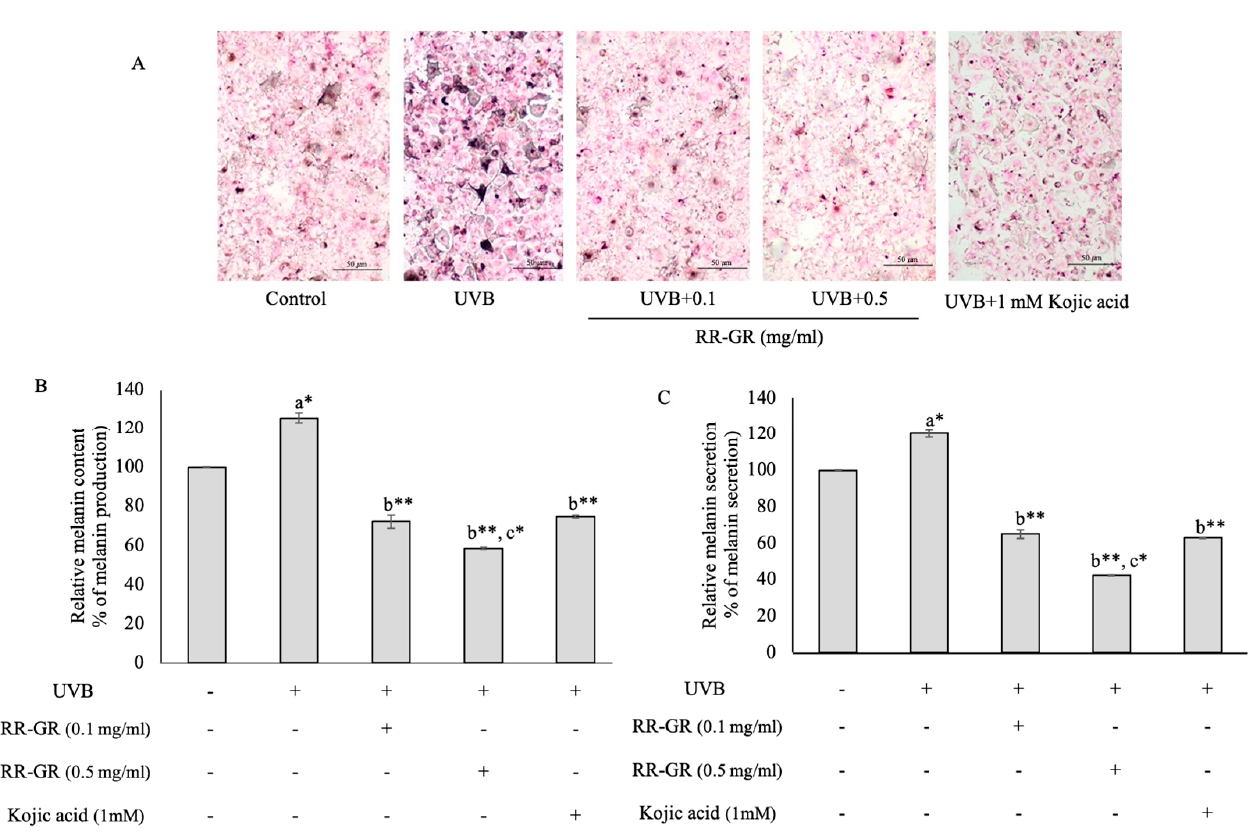
Figure 5. Melanin pigmentation and dendrite formation were determined by the Masson-Fontana assay. Control was present as untreated cells ( A ) The results of melanin production ( B ) and secretion ( C ) are present in the bar graph. The statistical significance of differences in each group was calculated by mean ± SD with the control (100%). a represents statistical significance compared with control. b represents statistical significance between radiated and treated cells. c represents statistical significance between treated cells. *, ** Statistical significance at p < 0.05 and p ≤ 0.001, respectively.